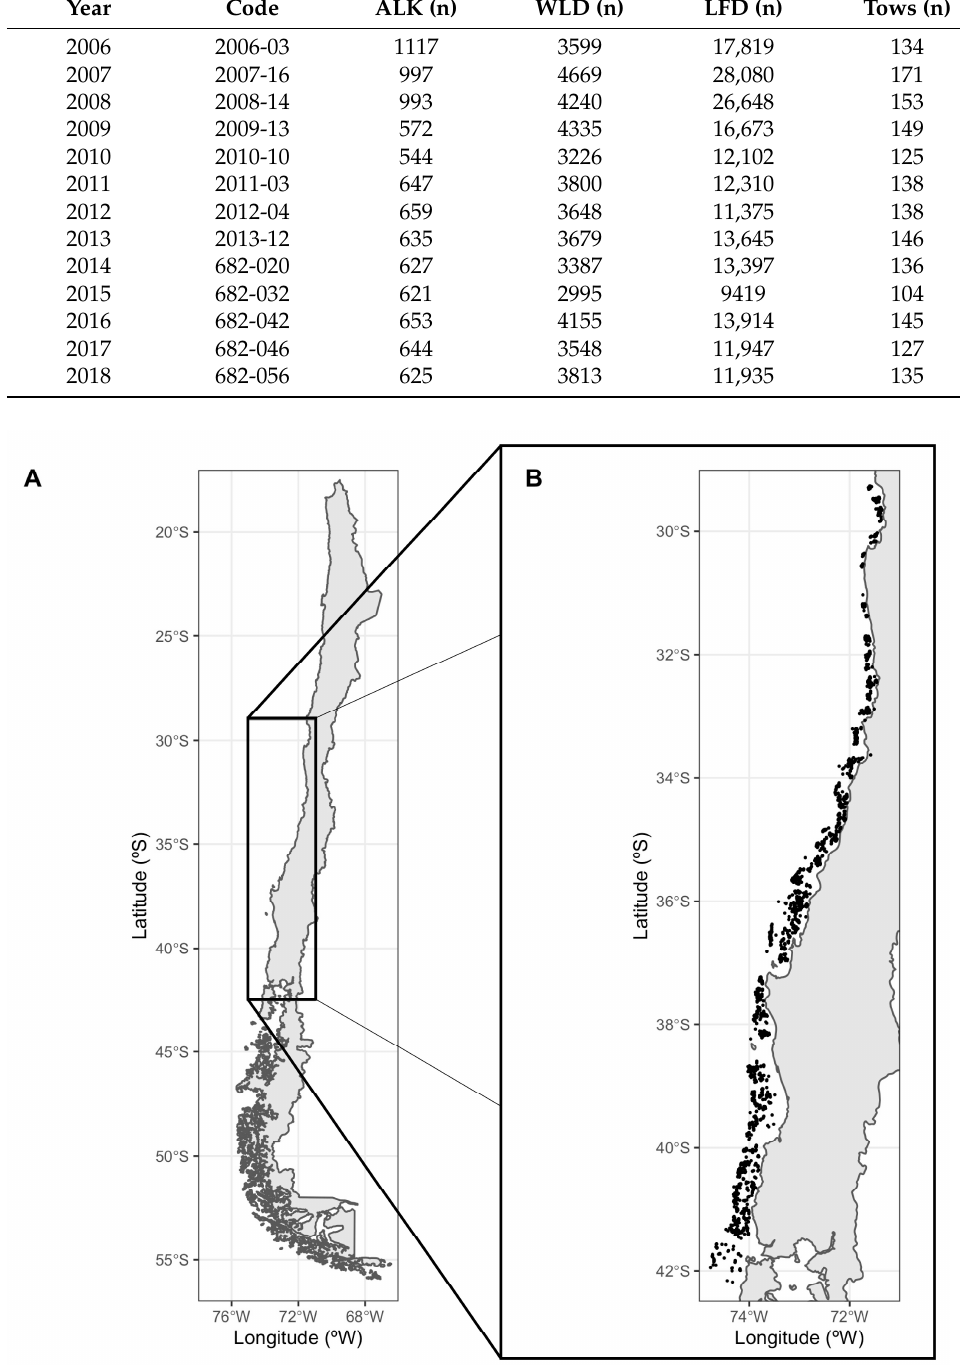
Figure 1. Study area shown in the square in Chile ( left ) and distribution of the fishing hauls ( right ) obtained during the Chilean hake stock assessment survey in the period between 1997 and